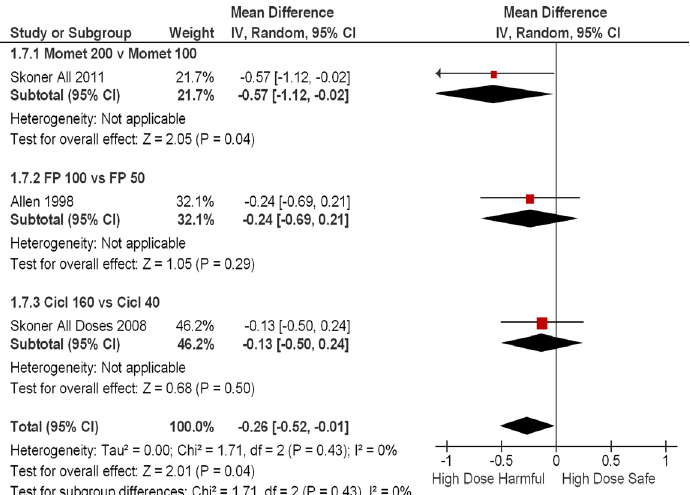
Fig 3. Mean Differences in Growth Velocity with Direct Comparison of Higher Dose vs. Lower